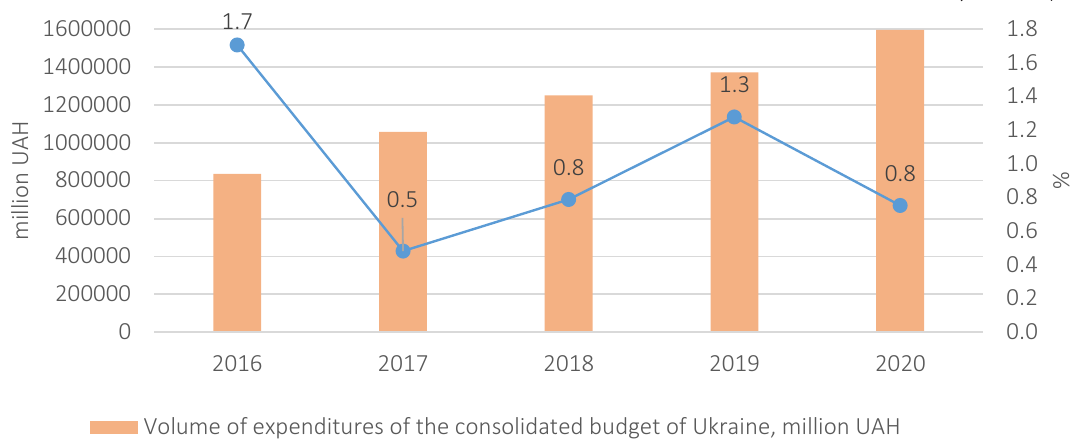
Figure 2. Share of TSA balances in total expenditures of the Consolidated Budget of Ukraine,